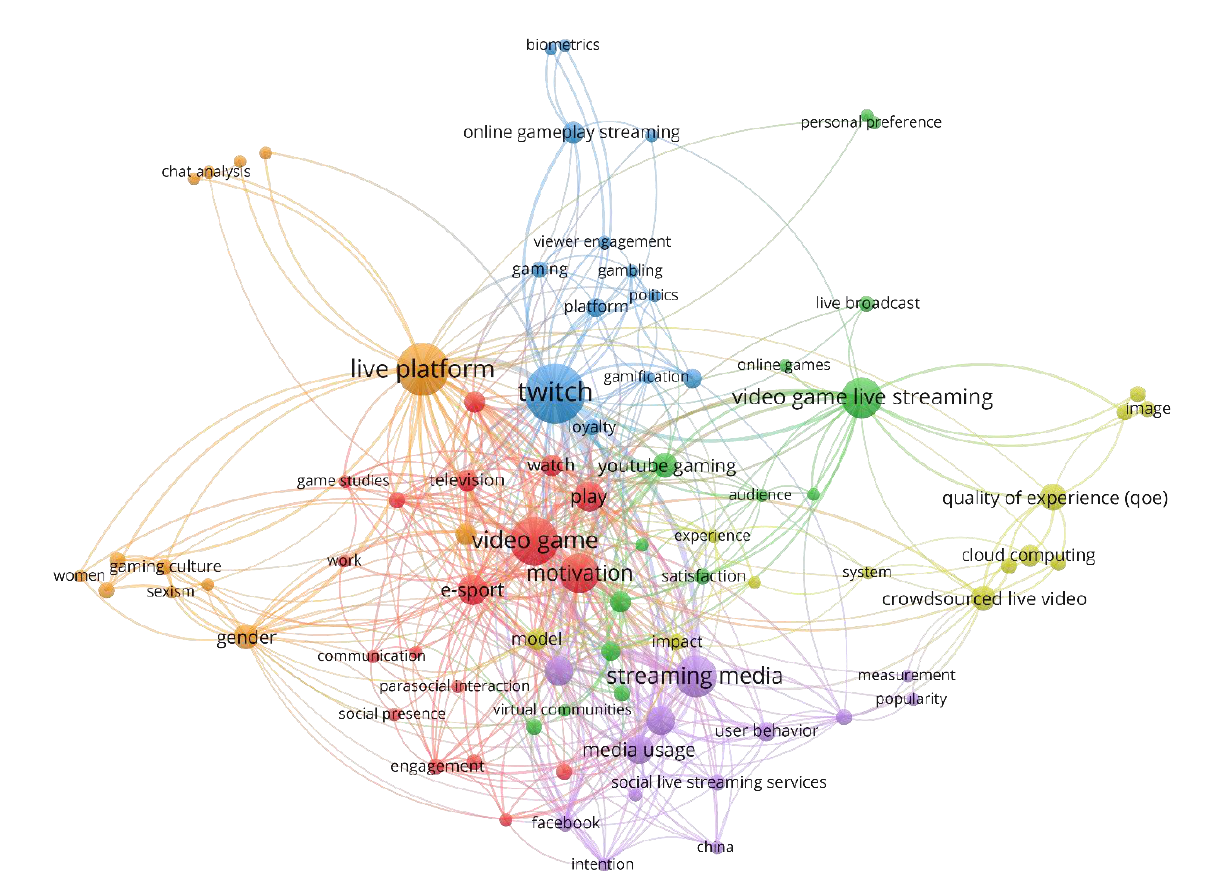
Figure 4. Map of thematic clusters identified in the research domain on video game live streaming.